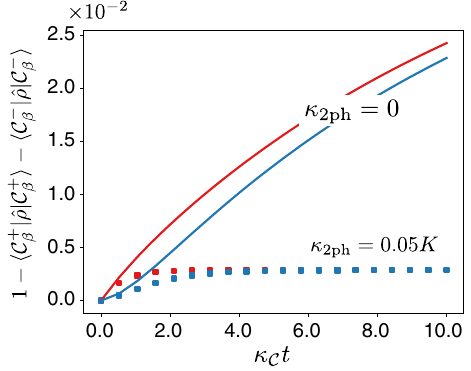
FIG. 13. Probability of excitations out of C subspace, given by ˆ ρ j C þ ˆ ρ j C − 1 − h C þ − h C − β j β i , obtained by simulating Eq. (C2) with β j β i 8 K , n 0 . 1 , and an addi- g ¼ 0 . 05 K , P ¼ K ( β ¼ 1 ), κ bc ¼ th ¼ tional two-photon dissipation (rate κ 2 ). The blue lines and blue ph dots correspond to when the PCO is initialized in the cat state j C þ β i with κ 2 ph ¼ 0 and κ 2 ph ¼ 0 . 05 K , respectively. The red lines and red dots correspond to when the PCO is initialized in the 0 and κ 0 . 05 K , respec- superposition state jþi with κ 2 2 ph ¼ ph ¼ tively. In practice, the stabilizer measurements typically take time T ¼ 1 =K – 10 =K , and so timescales such that κ C T ¼ 0 . 005 – 0 . 05 are